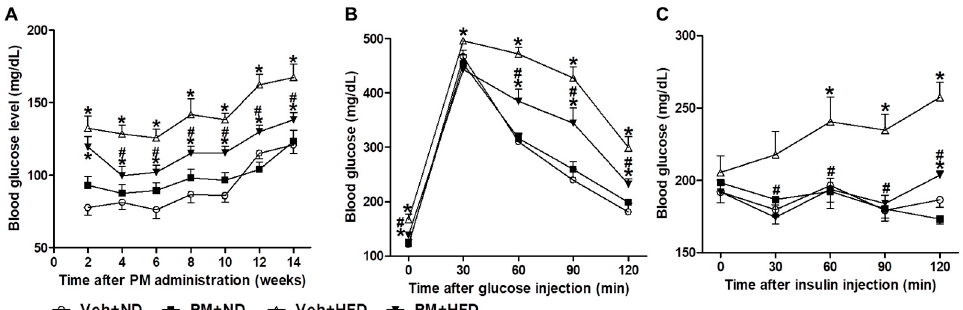
Figure 5. The effect of PM extract on hepatic triglyceride (TG) and lipid accumulation in HFD-fed mice. Hepatic TG levels ( A ) and representative images (magnification 200X) of H&E ( B ) and Oil-red O staining ( C ). The mice fed with ND or HFD were treated with PM extract or vehicle for 16 weeks, and the liver tissues were collected. Data are the mean ± SEM. * p < 0.05 vs. Veh + ND group; # p < 0.05 vs. Veh + HFD group.